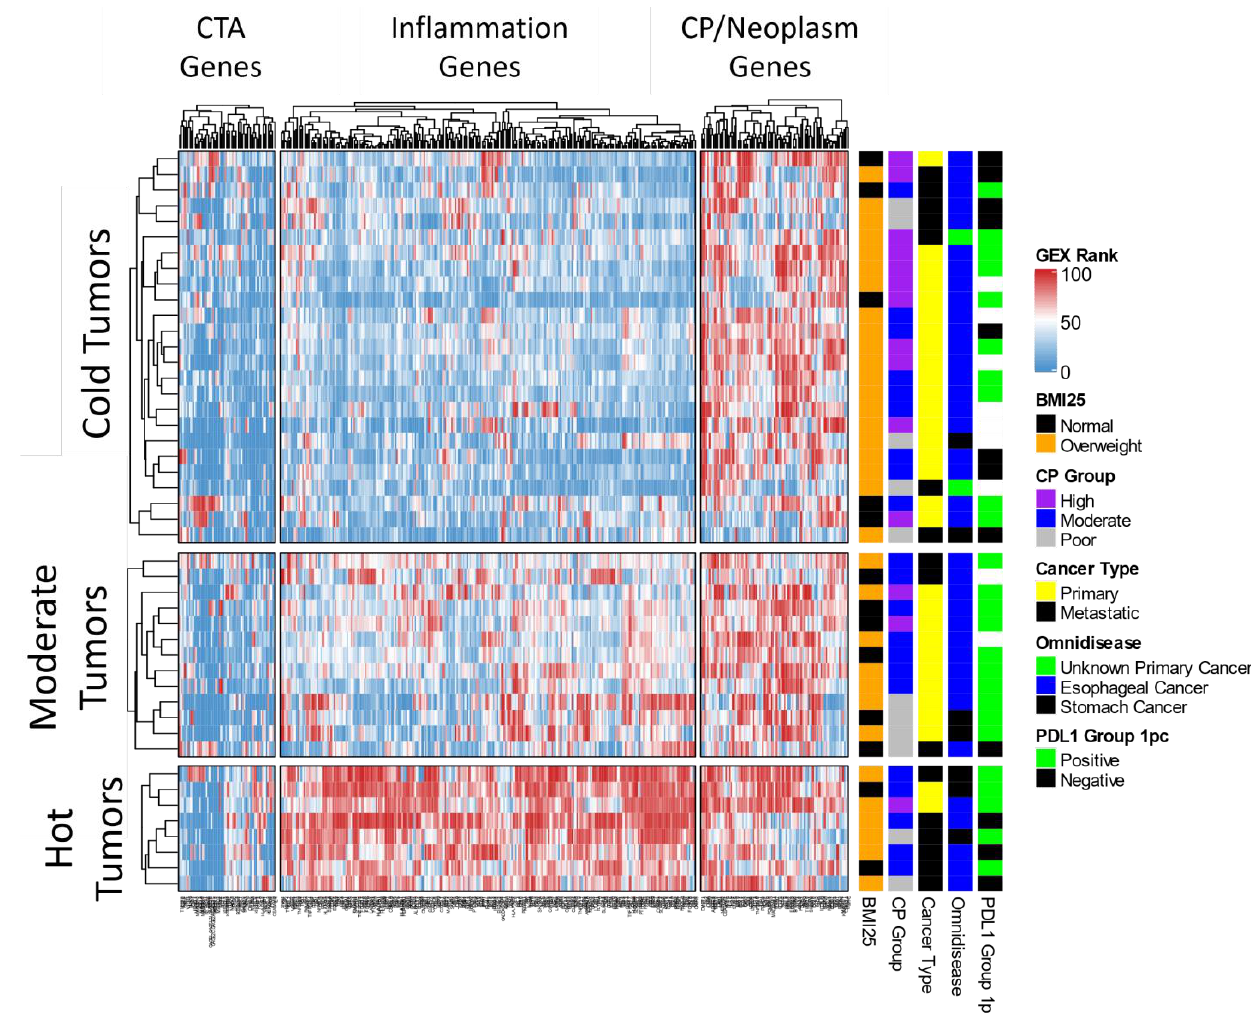
Figure 2. Unsupervised clustering of 395 genes (columns) across 46 samples (rows) leading to discovery of hot, moderate and cold tumor subtypes. Annotated for each sample are BMI, cell proliferation status, cancer type, disease type (omnidisease), and PDL1 (positive: ≥1%).